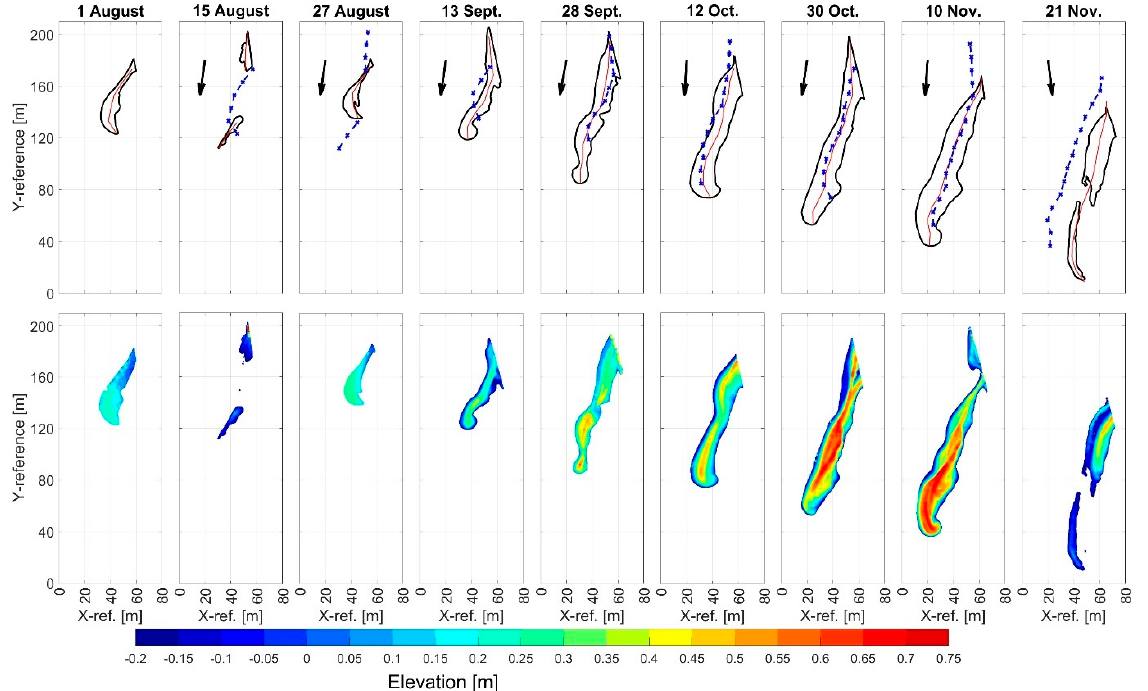
Figure 5. Spit evolution throughout the study. Upper panels: contours (black line) and center of the spit (red line); starting on 15 August, each upper panel presents the centerline of the previous spit (blue dashed line). Wave direction between surveys is shown with a black arrow next to the spit. Lower panels: spit elevation, used for the volume calculation. XY values are in meters, measured from the west jetty head (red star in Figure 3).